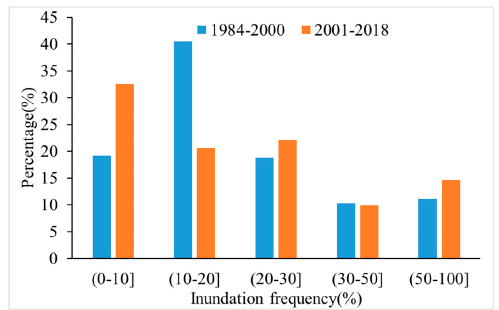
Figure 4. Percentage of the five categories of inundation frequency in the pre- and post-ecological water replenishment. During the pre-EWR period, areas with inundation frequency in the 10 – 20% and 20 – 30% classes accounted for 41% and 19% of the total inundation area, respectively. During the post-EWR period, areas with an inundation frequency of 0 – 10% and 10 – 30% accounted for 33% and 22% of the total